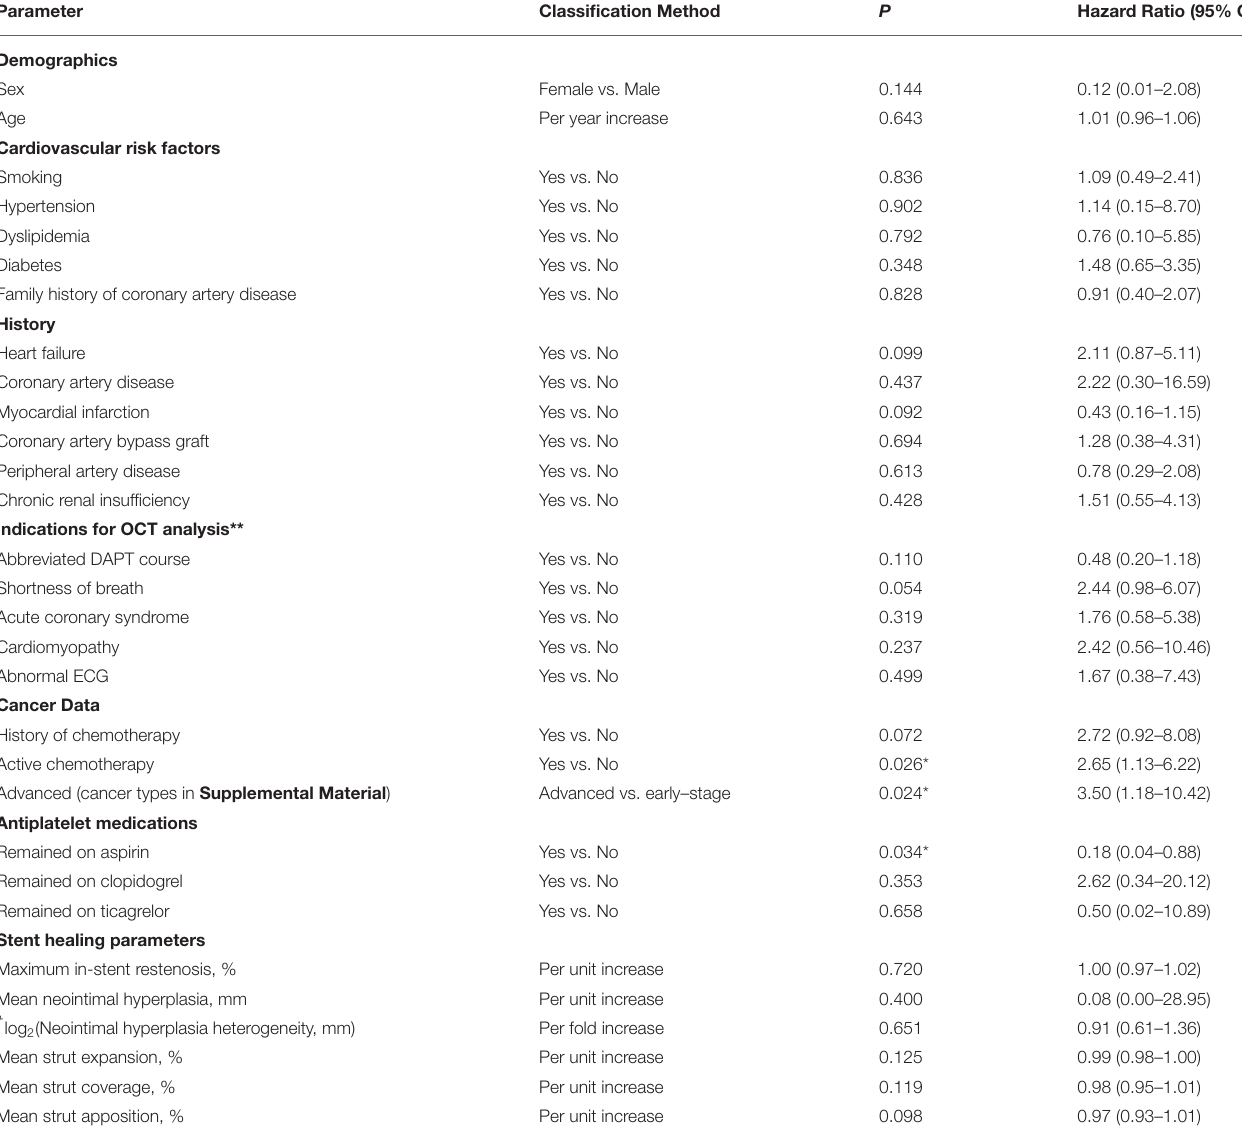
TABLE 4 | Cox proportional Hazard model to determine associations of baseline characteristics and stent healing parameters with survival.